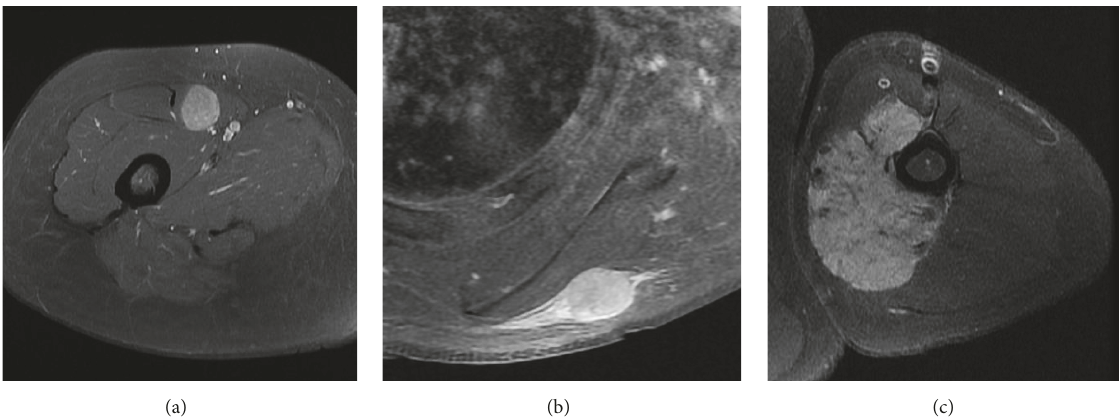
Figure 2: Representative images of different tumor borders on MRI. (a) T1 enhanced MRI of an intramuscular synovial sarcoma with pushing border on MRI. (b) T1 enhanced MRI of an intramuscular undifferentiated pleomorphic sarcoma with infiltrative border on MRI with the tail sign. (c) T1 enhanced MRI of a leiomyosarcoma with infiltrative border on MRI without the tail sign.